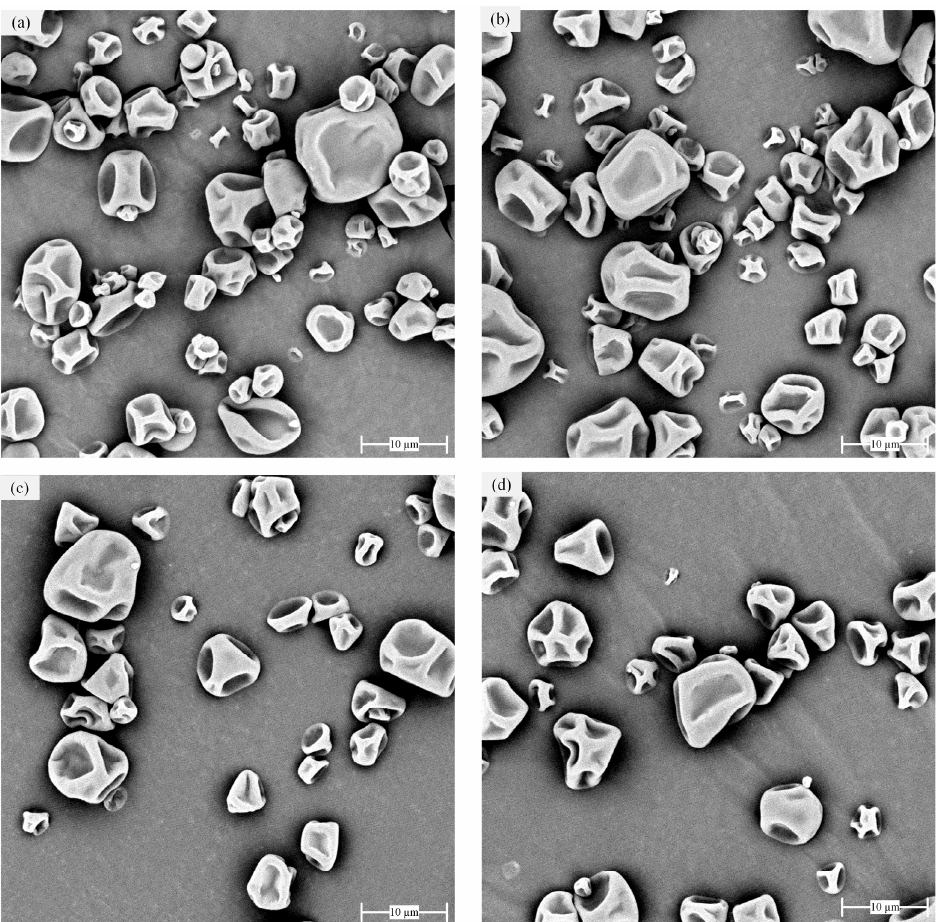
Figure 11. SEM image of particle collected from different designs with maximum gas flow rate; ( a ) Design 1: Four-inch connection; ( b ) Design 2: Six-inch connection; ( c ) Design 3: Box connection; ( d ) Design 4: Conical drying chamber.